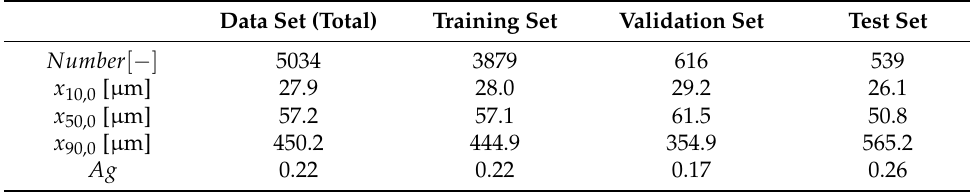
Table A1. Characteristics of dataset.